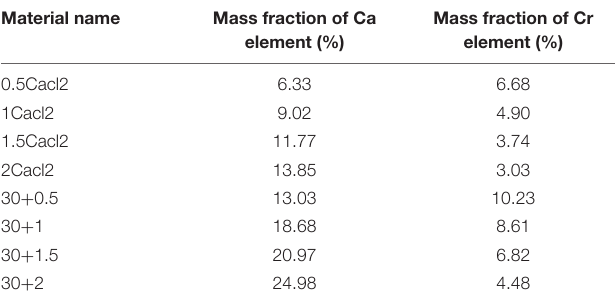
TABLE 7 | Element content analysis of composite